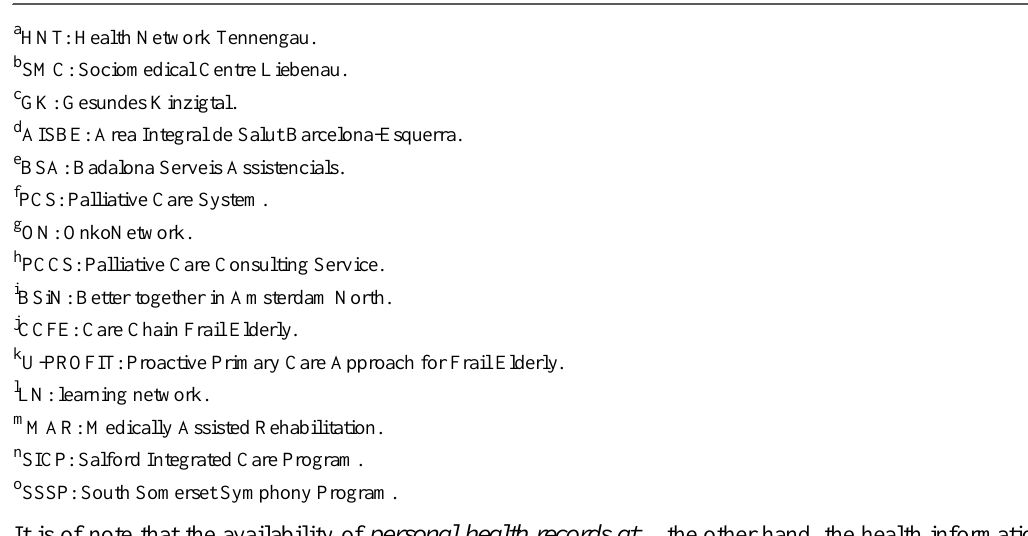
Information and researchTechnologies and medical